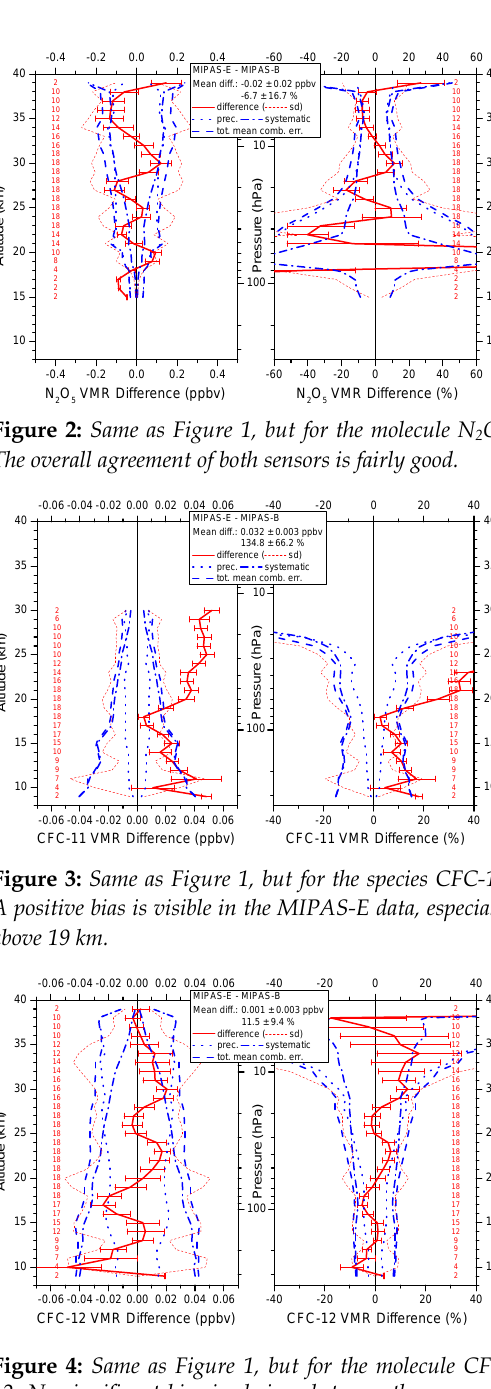
Figure 4: Same as Figure 1, but for the molecule CFC- 12. No significant bias is obvious between the measured profiles of both MIPAS